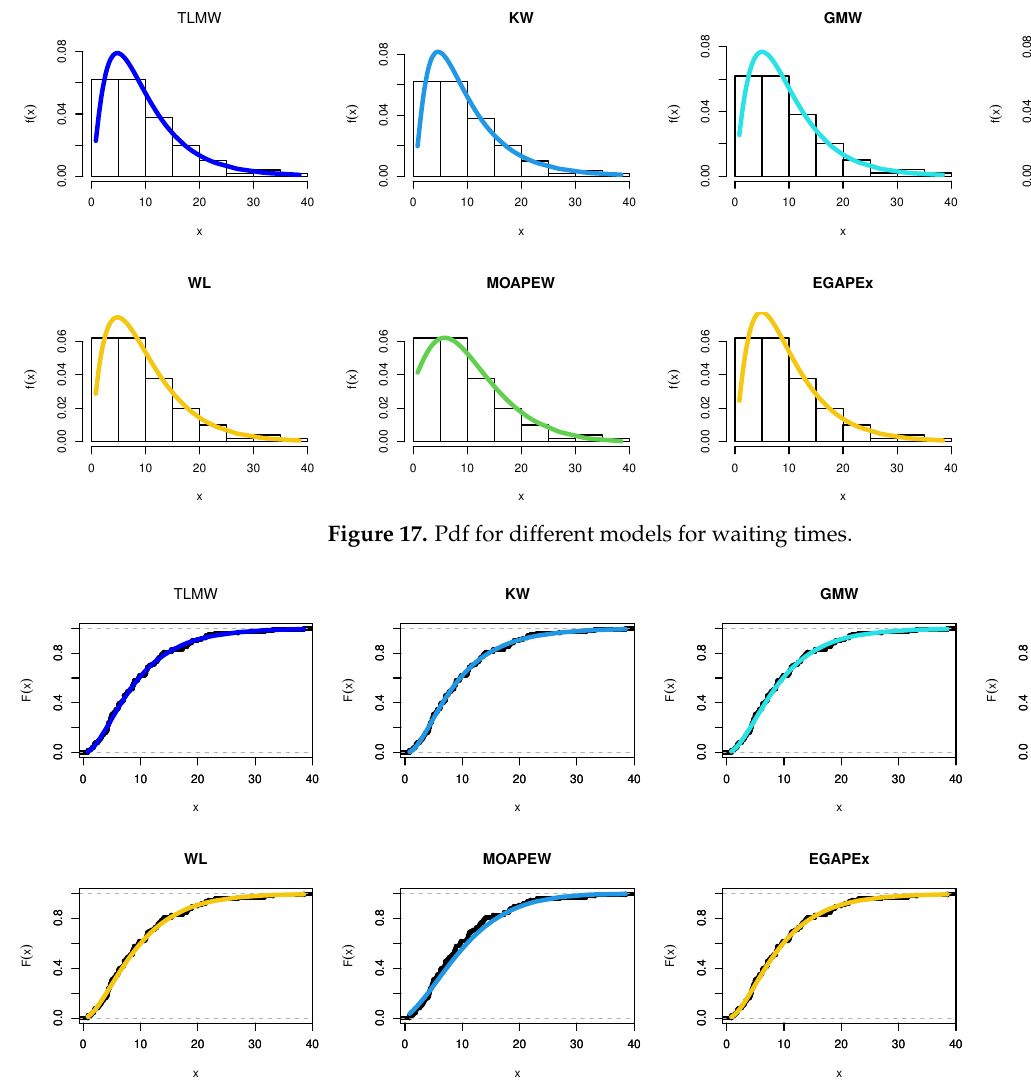
Figure 18. Cdf for different models for waiting times. PP−plot